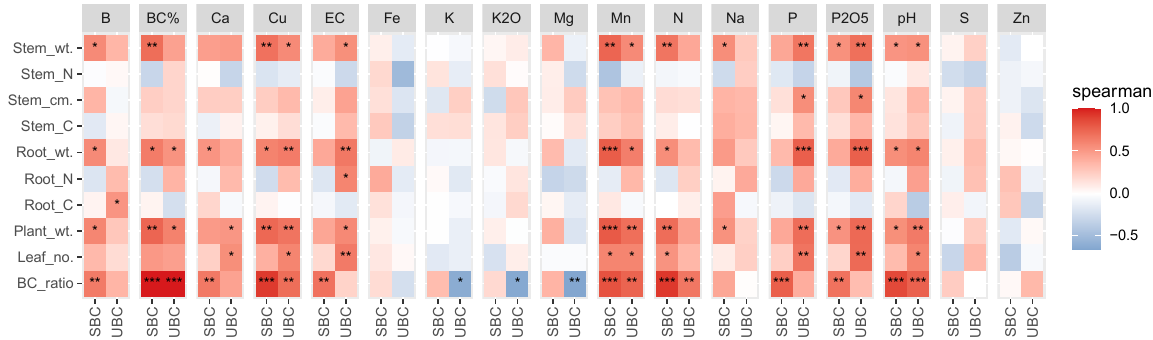
Figure 2. Percent increase in the N and P concentration in 10-week samples in comparison to the control.